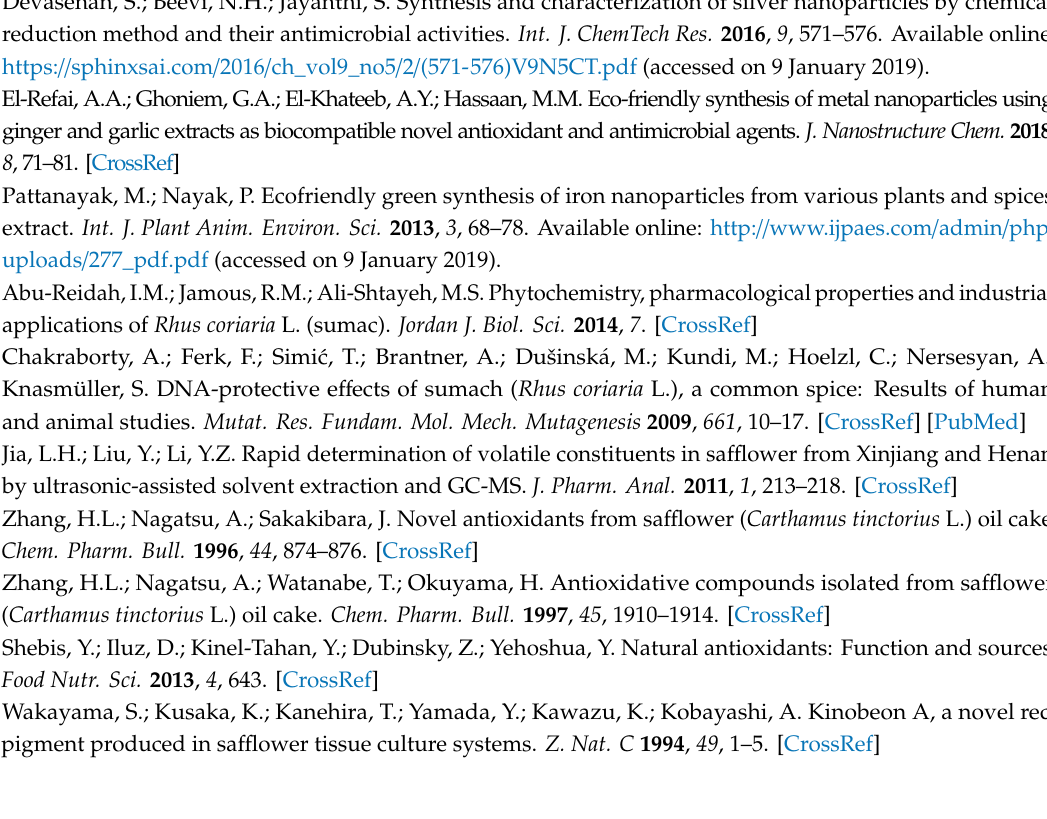
Table S1: Standard curve of gallic acid, Table S2: Standard Curve of